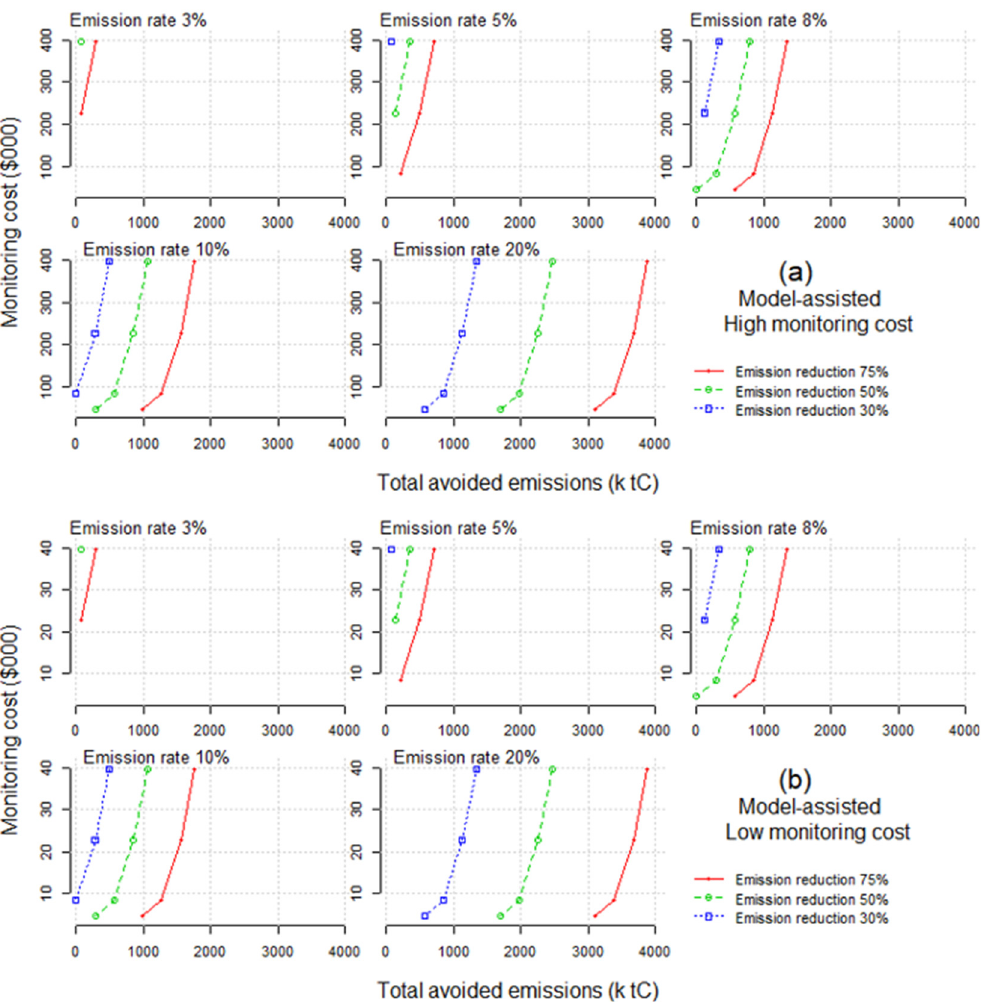
Figure 4. Total avoided emissions versus monitoring costs adopting a model-assisted technique.